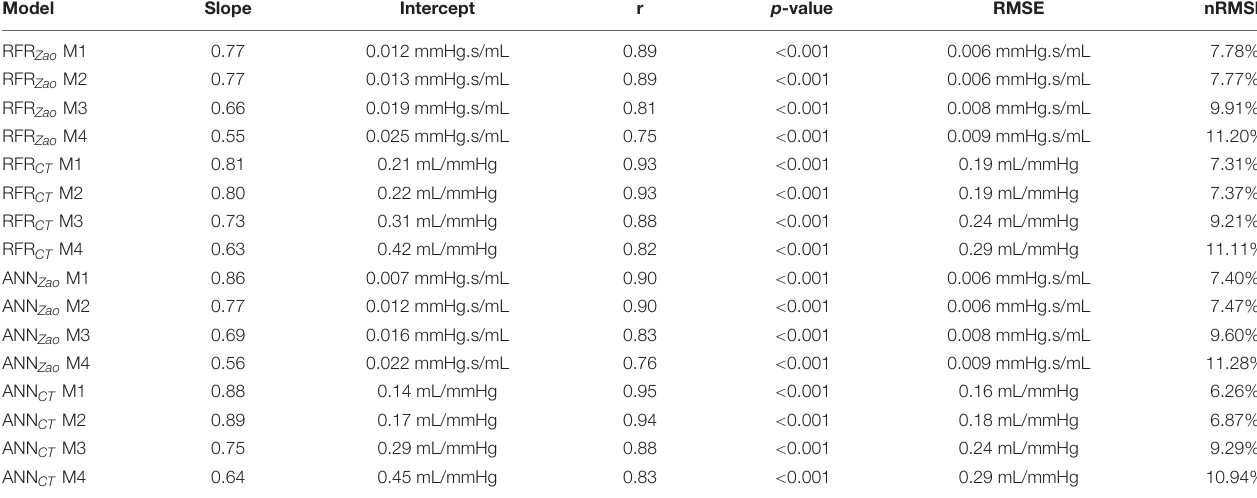
TABLE 4 | Regression statistics between model predictions and reference values.